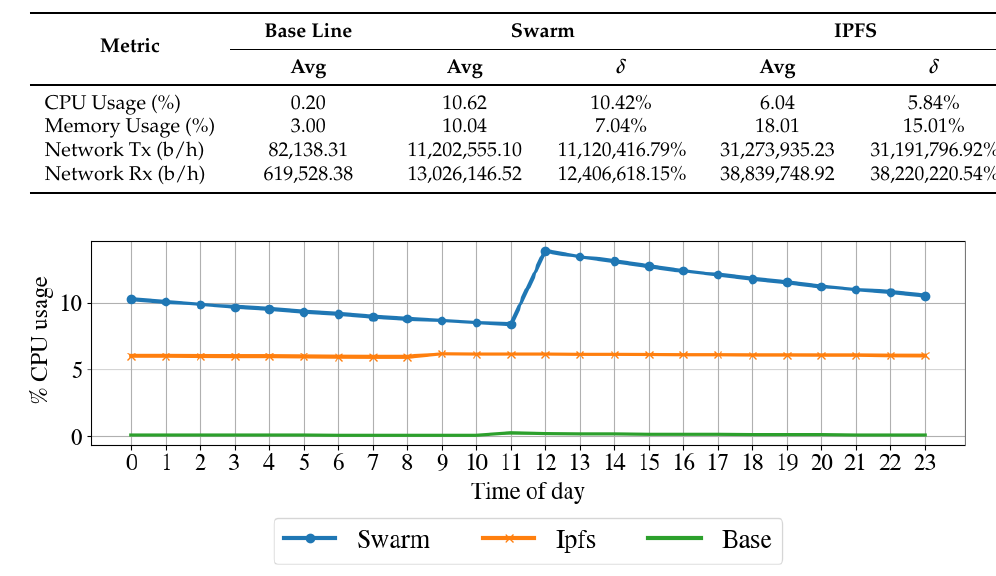
Table 3. Resource impact on the node in terms of CPU and memory usage, and transmitted and received bit per hour before (Base Line) and while running the proposed architecture with IPFS and Swarm.